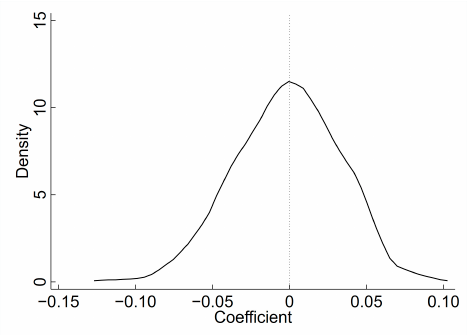
Figure 3. Placebo